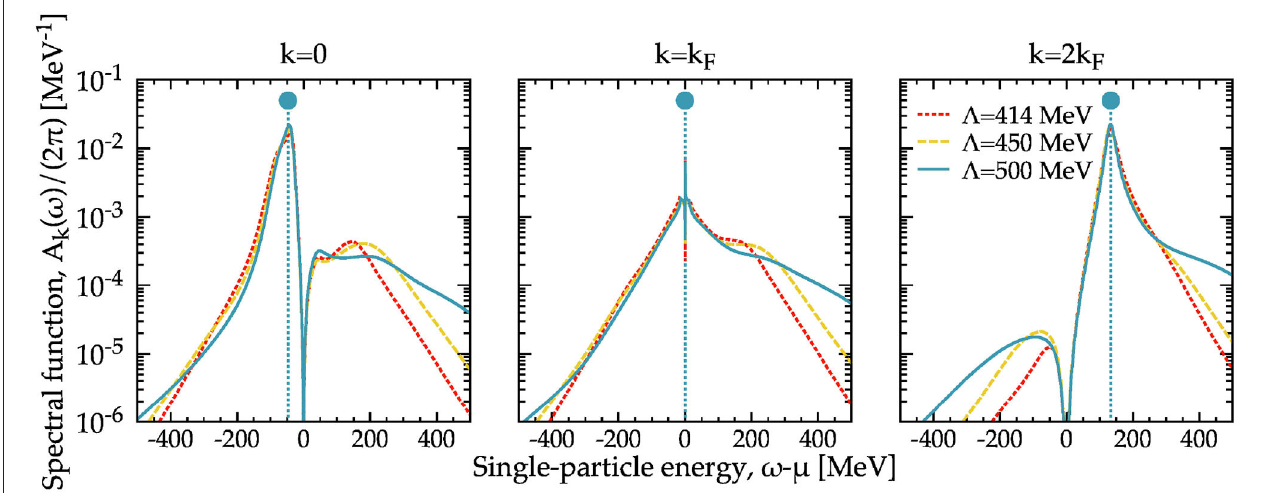
FIGURE 3 | Spectral function A k ( ω ) as a function of energy for three different momenta: k = 0 (left) k = k F (central) and k = 2 k F (right) . SCGF calculations are performed at a density ρ = 0.16 fm − 3 and have been extrapolated to zero temperature. Results for N3LO NN plus N2LO 3NFs have been performed with three different cutoffs. The vertical line and solid dot indicate the position of the quasi-particle peak ω = ε k , for each of these momenta. The height of this peak has been chosen